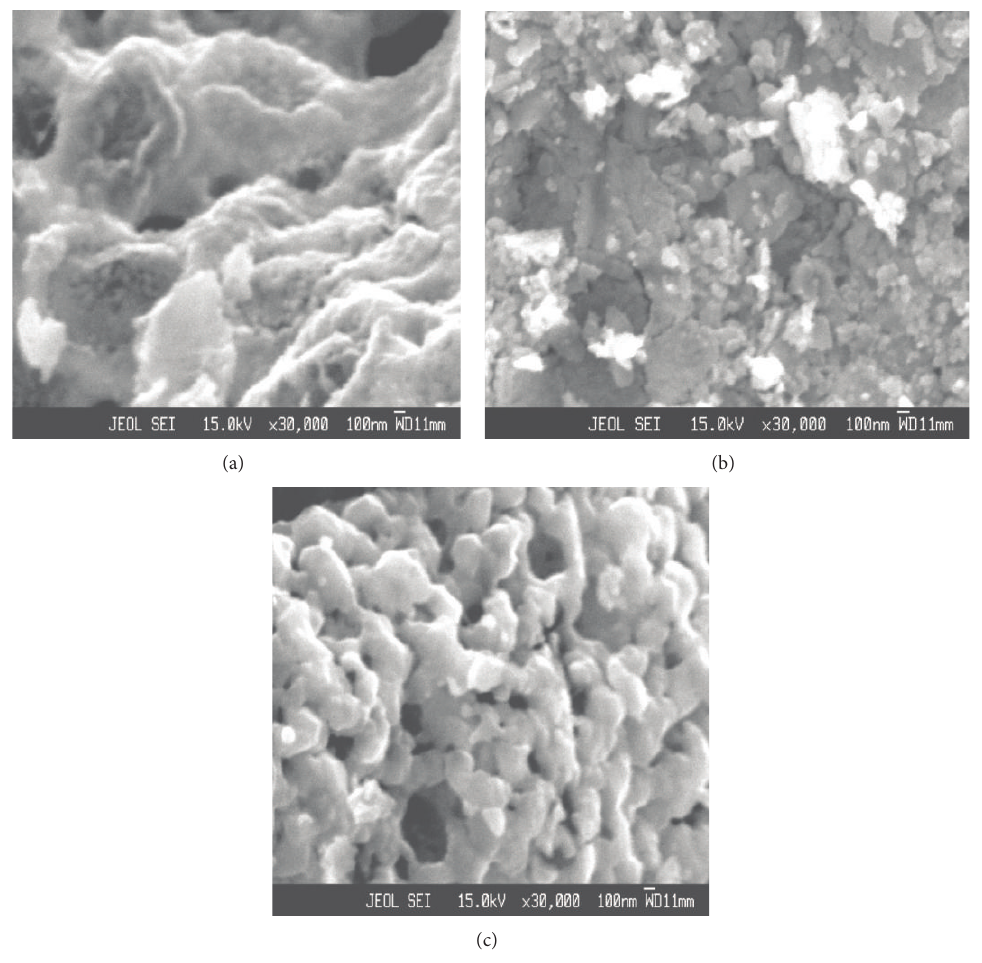
Figure 2: SEM micrographs of (a) Zn 1.0 Cu 0.0 Fe 2 O 4 , (b) Zn 0.75 Cu 0.25 Fe 2 O 4 , and (c) Zn 0.25 Cu 0.75 Fe 2 O 4